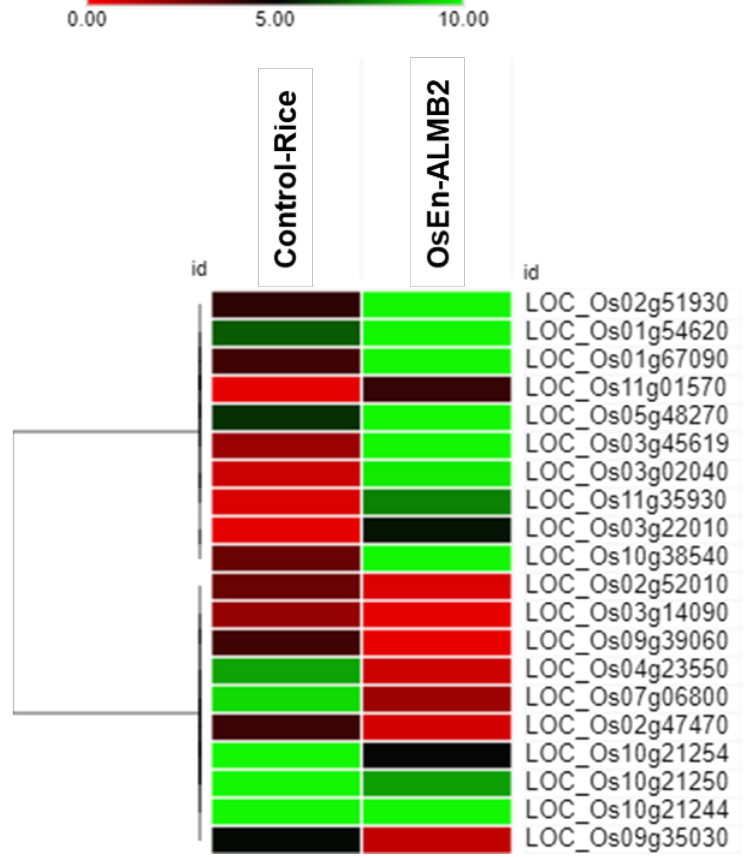
Figure 8. Heat map plotted with absolute FPKM expression